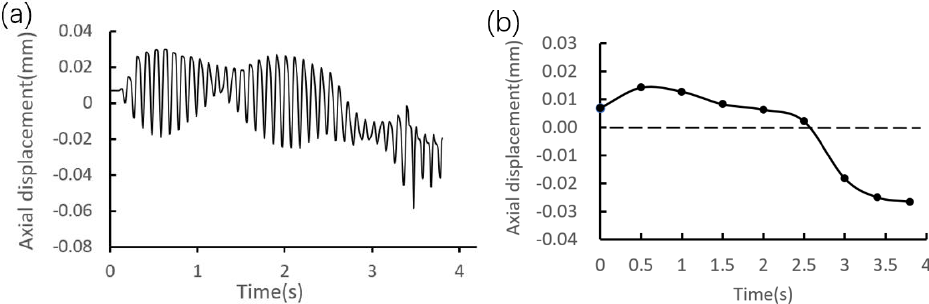
Figure 17. Axial displacement distribution at point C. ( a ) Global change. ( b ) Average value